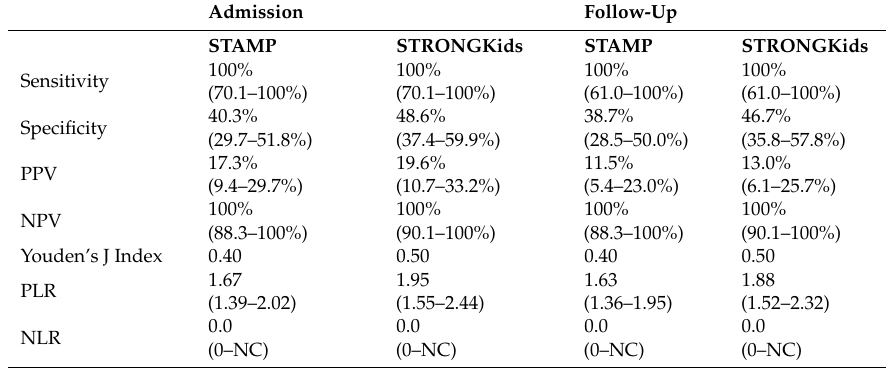
Table 3. Diagnostic e ffi cacy parameters for both tools to detect acute and / or chronic malnutrition considering those classified as medium or high risk. In brackets, the confidence intervals for 95% are